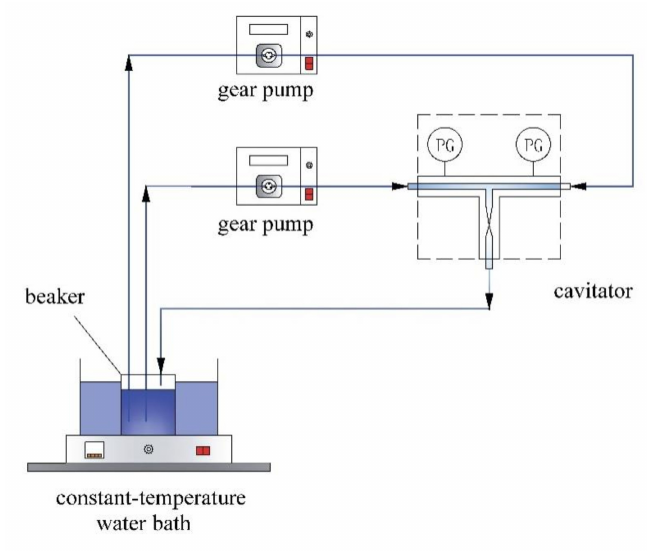
Figure 1. Schematic diagram of the impact-jet HC